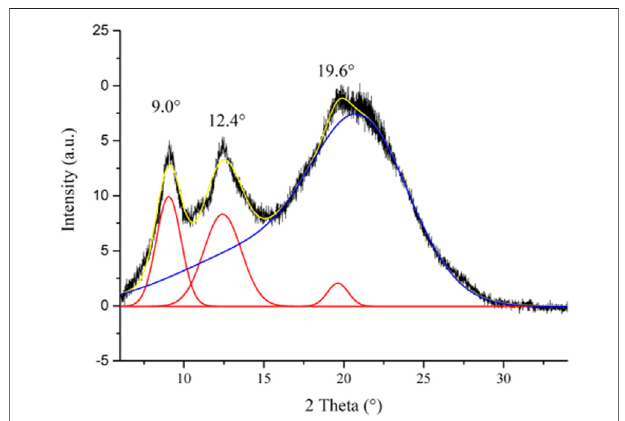
FIGURE 3 | XRD pro fi le of the control CS fi lm with its deconvolution curves (crystalline peaks: red lines; amorphous region: blue curve; cumulative fi t curve: yellow line).